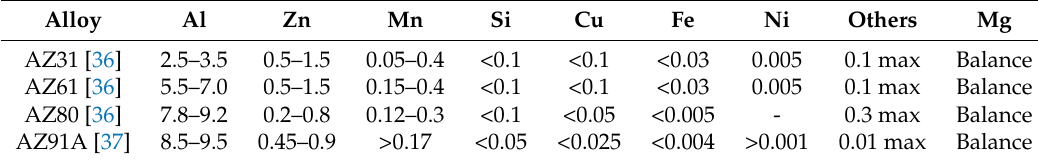
Table 2. Nominal chemical compositions of commercial Mg-Al-Zn alloys given in